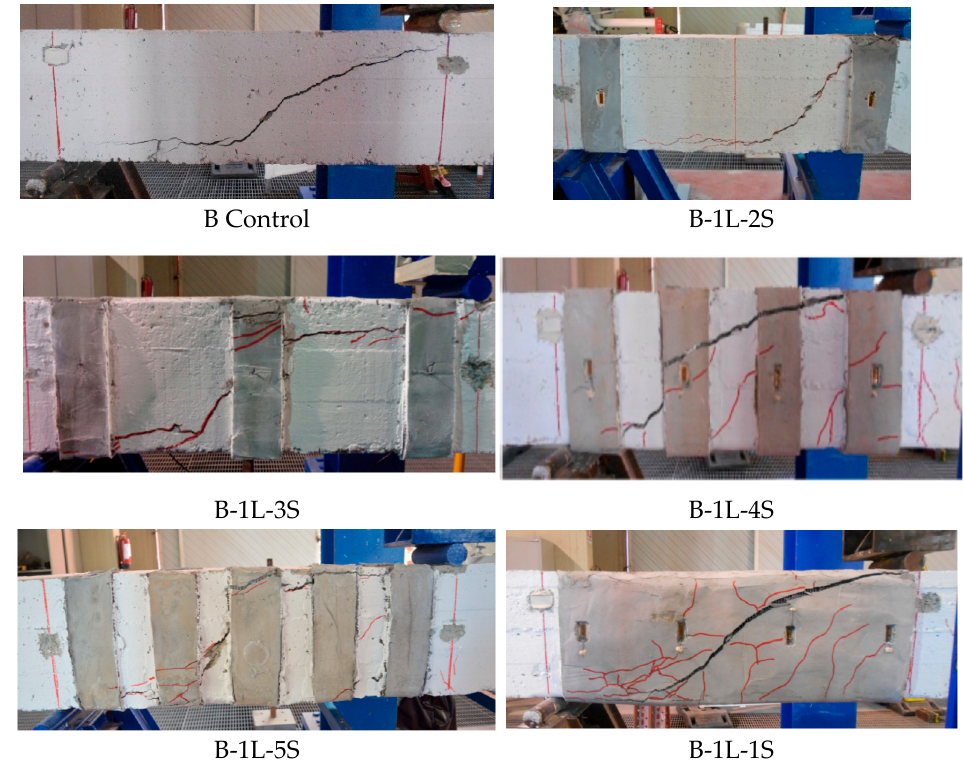
Figure 7. Failure configurations of beams strengthened with one-layer SRG U-shaped